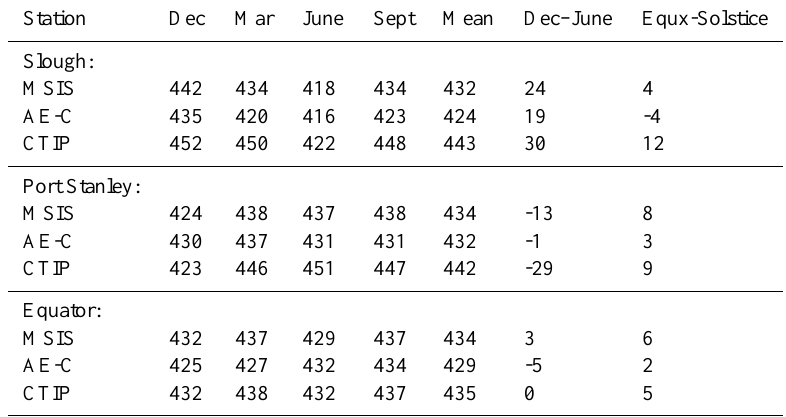
Table 1. P -parameters at midday from models and data. Station Dec Mar June Sept Mean Dec–June Equx-Solstice Slough: MSIS